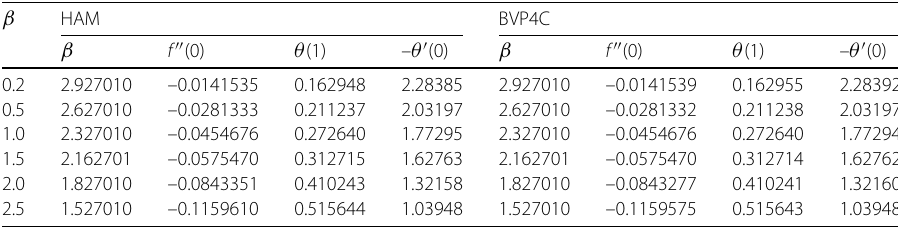
Table 5 Comparison of the values of β = Υ Mathematica package BVPh2.0 approximation and shooting method for the case λ = 0.2, I 0 = 0,